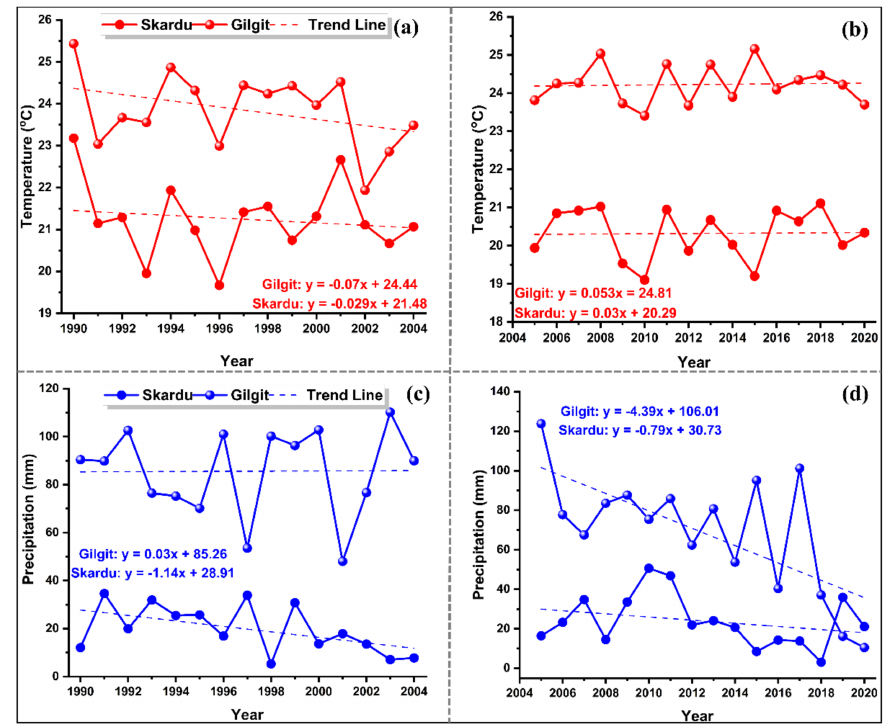
Figure 8. Climate variable (temperature and precipitation) time series; ( a ) temperature from 1990–2004, ( b ) temperature from 2005–2020, ( c ) precipitation from 1990–2004, and ( d ) precipitation from